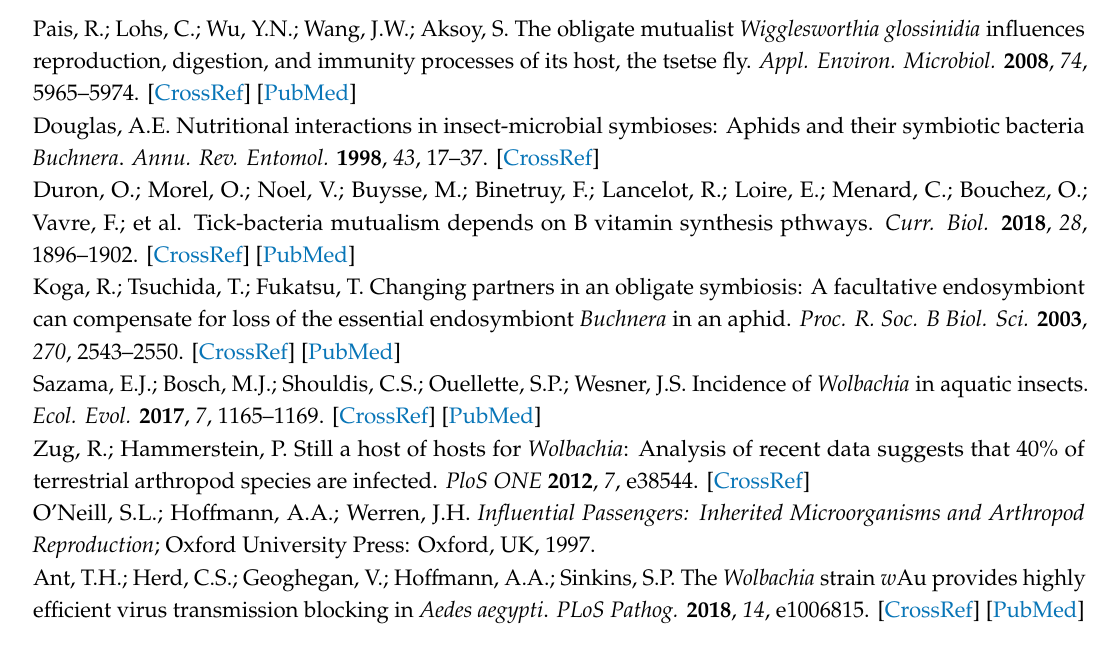
Figure S1: Fungus-infestation levels on grapes with three levels recognized: ( a ) Level 1, less than 1 piece of 6 pieces of grapes was covered by visible mycelial growth; ( b ) level 2, 2 to 4 pieces of grapes were covered by visible growth; ( c ) level 3, 5 to 6 pieces of grapes were covered by visible